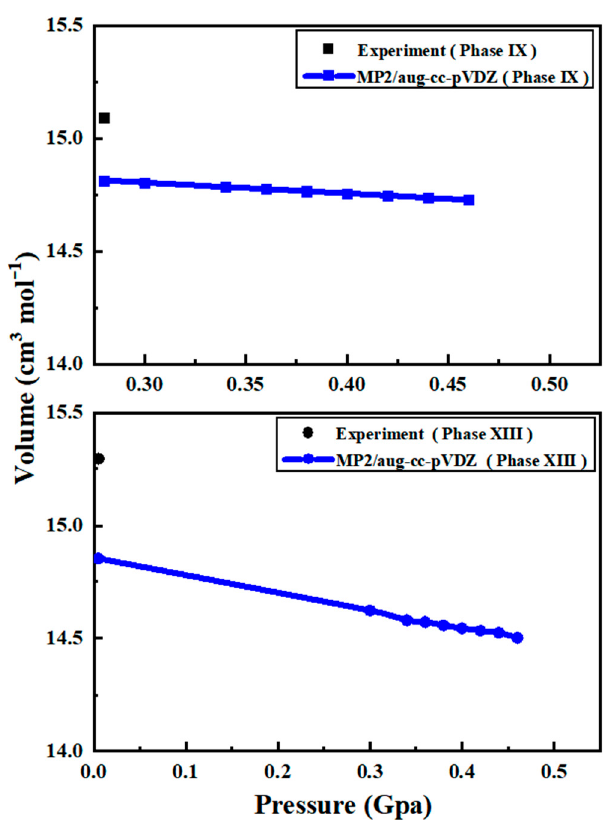
Figure 1. The calculated volumes of ice phases IX (a) and XIII (b) as a function of pressure, along with the experimental data which are taken from Ref. [7] (phase IX) and Ref. [8] (phase XIII).